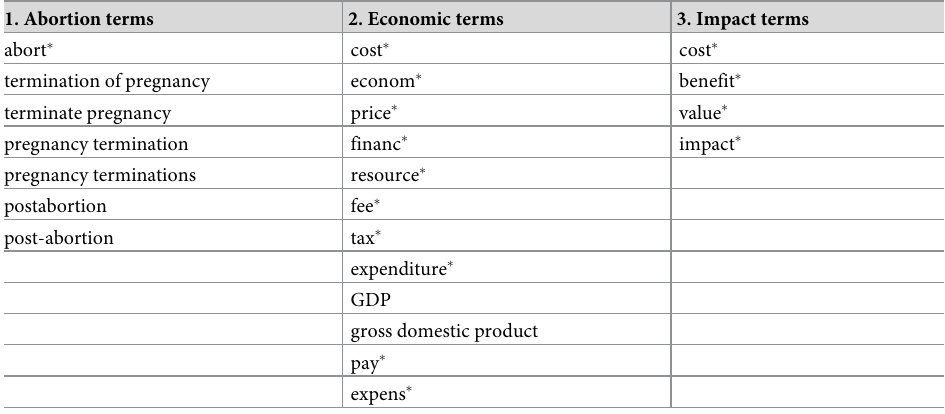
Table 2. Search terms and their